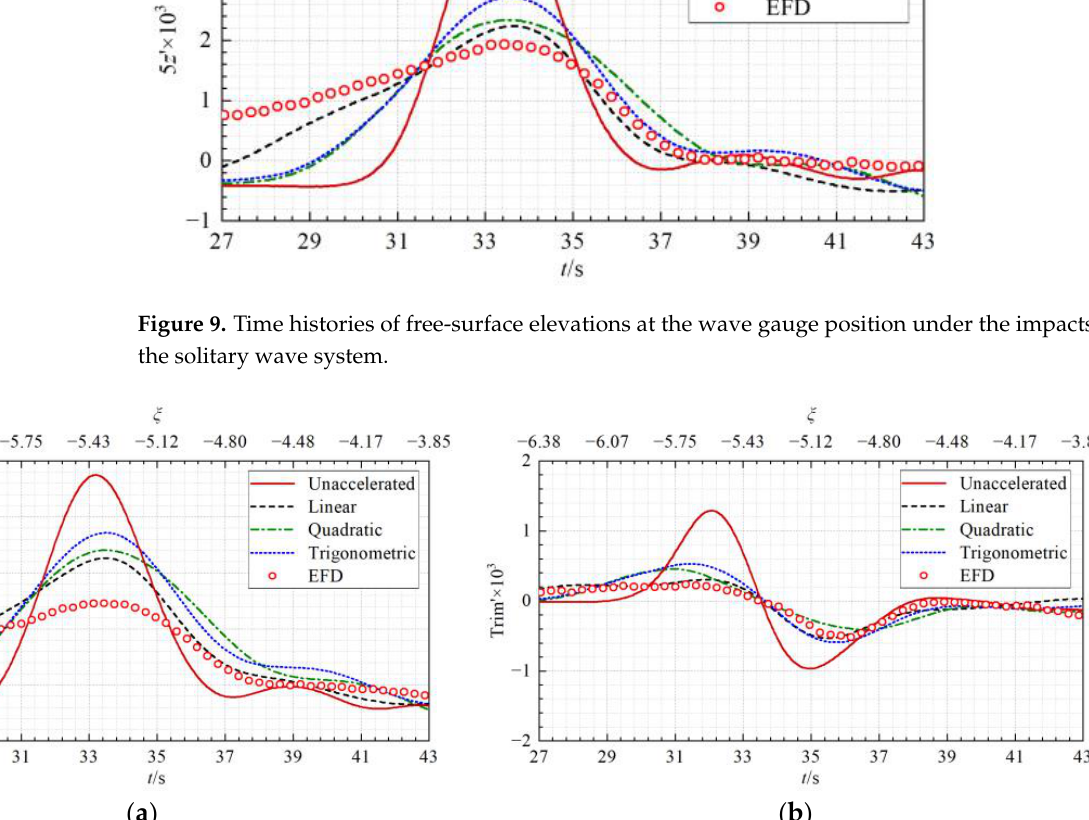
Figure 10. Time histories of attitudes of the moored ship under the impacts of the solitary wave system. ( a ) Sinkage’, ( b ) Trim’. ( a )